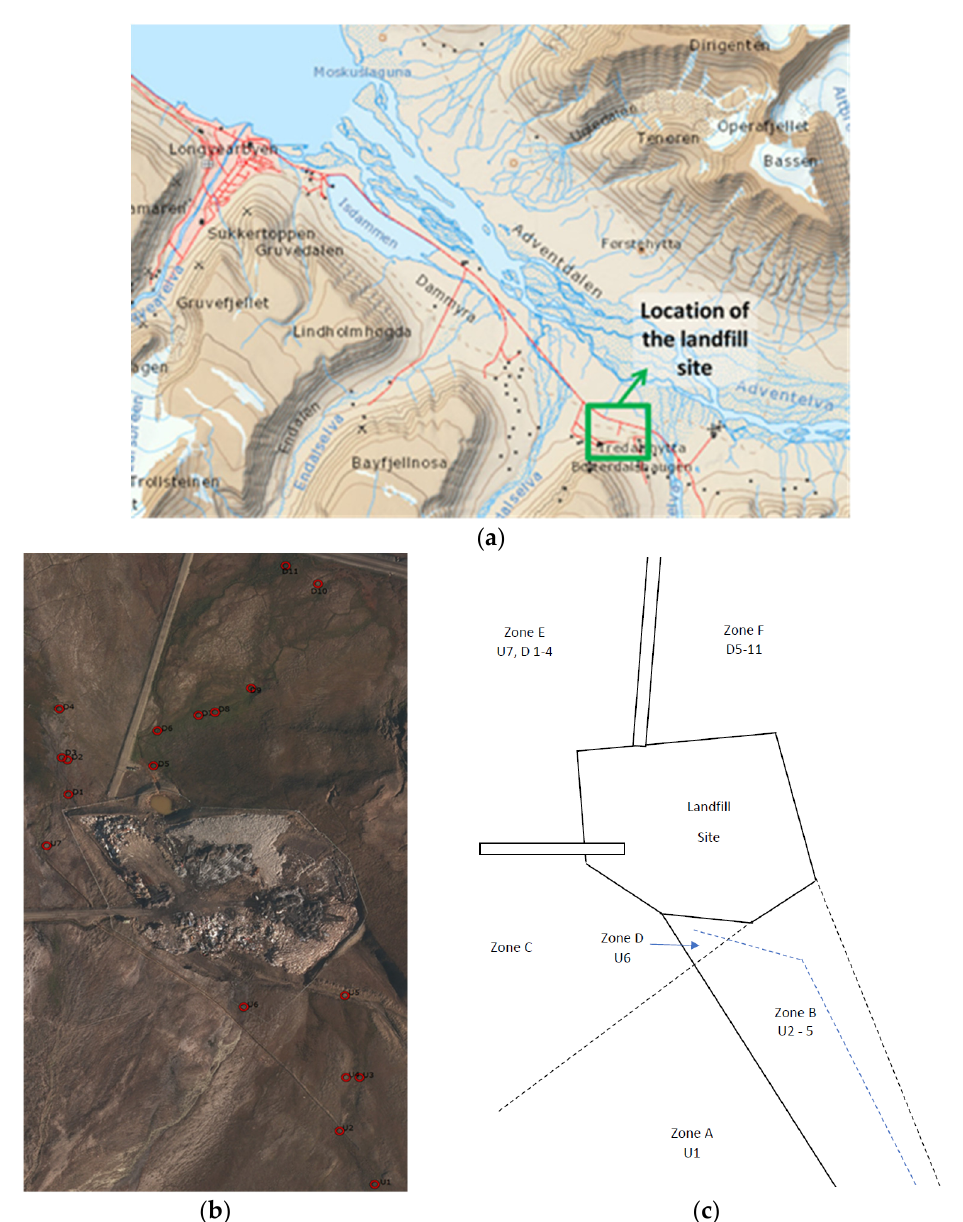
Figure 1. ( a ) the location of the landfill site on Svalbard (Longyearbyen to the landfill site is ~10 km), ( b ) an aerial view of the sample locations and ( c ) a schematic showing the position of the different zones.